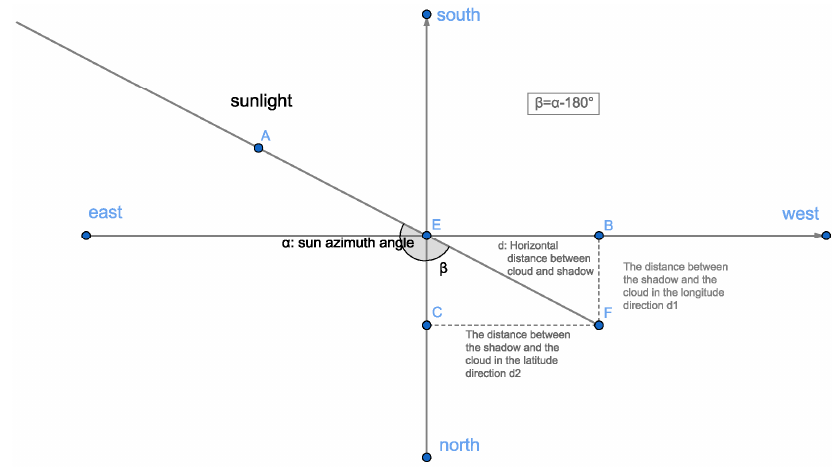
Figure 9. Demonstration of the shadow orientation. The experimental contents and steps are as follows. Two platforms were placed under the flagpole and adjusted to horizontal using a level ruler. The cameras were placed on a horizontal platform, and the lens was placed facing vertically upward to capture the top of the flagpole. The distance between two horizontal platforms as well as the length and extension direction of the flagpole in the ground shadow were measured and recorded. Any distortion of the captured picture was corrected, and then the height h of the flagpole was calculated. The solar altitude angle at that time was calculated according to the longitude and latitude of the shooting location and the shooting time α and azimuth β . Then, the shadow length and extension direction were calculated. The local coordinate system was built with the flagpole as the origin, and the calculation results and measurement results were expressed in the local coordinate system for comparison. The pictures taken by the left and right cameras are presented in Figure 10.